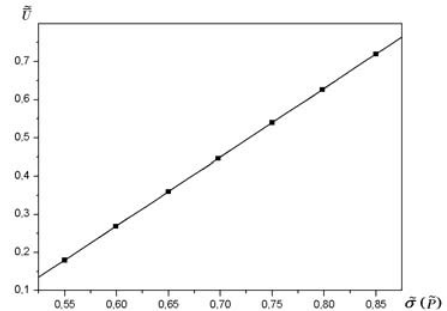
Fig 2. The regularity of the resulting average amplitude of the AE signal from the value of contact stress expressed in relative values. Data processing was carried out by the modelling results, in accordance with (1)